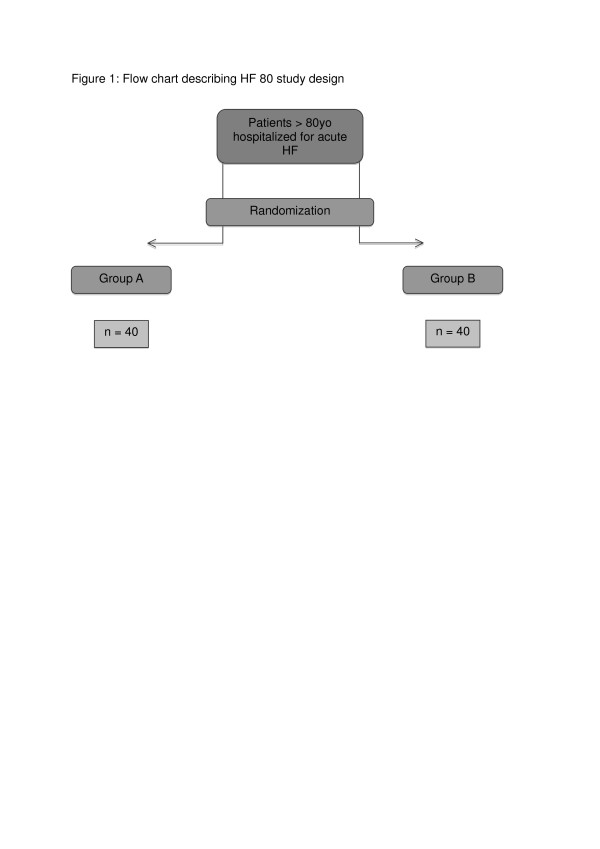
Flow chart describing HF 80 study design. HF: heart failure.